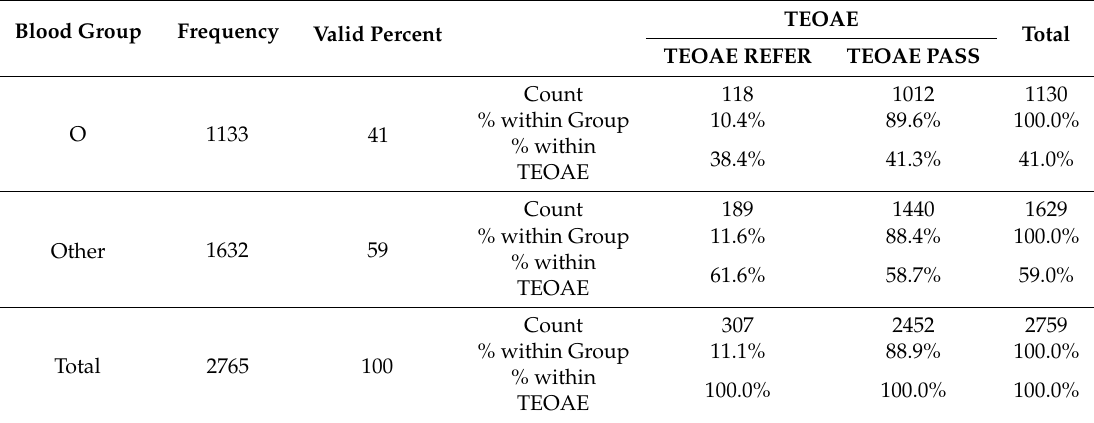
Table 2. Crosstab blood group O vs.